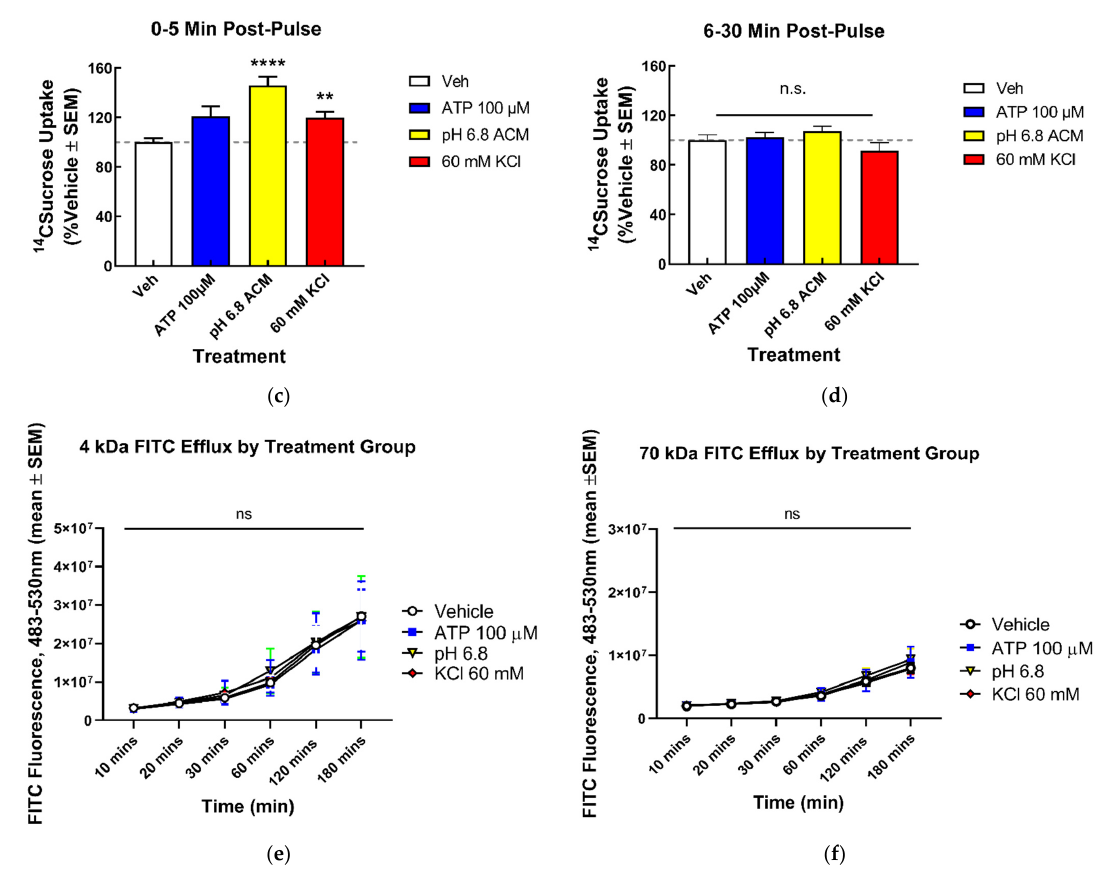
Figure 1. Screening and functional consequences on BEB following treatment with pronociceptive substances released during CSD. ( a ) Cross-sectional diagram of Transwell culture and TEER assay. ( b ) Both 60 mM KCl and acidified pH induced a rapid, significant drop in TEER following abluminal treatment, while 100 μ M ATP demonstrated a gradual TEER drop, and 100 μ M glutamate had no significant effect (60 mM KCl vs. Veh: mean of differences: − 32.5 ± 5.463, ** p = 0.0010; n = 3/4: glutamate vs. Veh: mean of differences = 1.612 ± 1.403, p = 0.2941, n = 3: pH = 6.8 vs. Veh: mean of differences = − 25.77 ± 4.392, ** p = 0.0011, n = 3/4: 100 μ M ATP vs. Veh: mean of differences = − 10.39 ± 2.483, ** p = 0.0058, n = 3: all data analyzed with two-tailed paired t -test ± SEM). Abluminal 14 C-sucrose